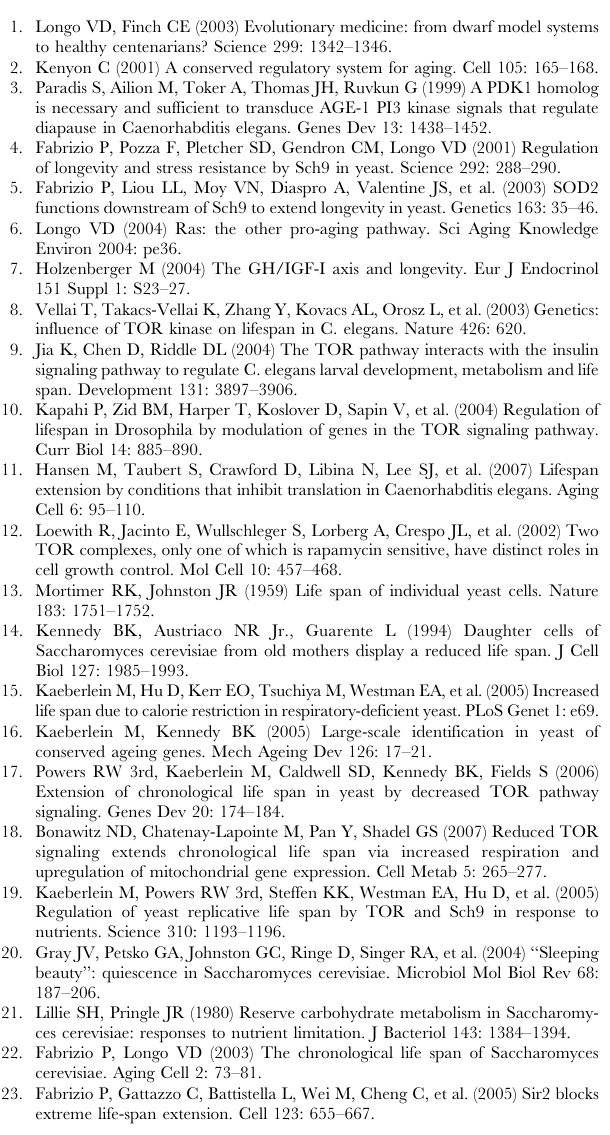
Table S7 Schematic representation of ergosterol biosynthesis and expression levels of genes involved in the process. Data were expressed in fold change, WT= 1. For illustration purpose, gene expression levels that are 20% higher or lower than wild type cells are marked in red or green,